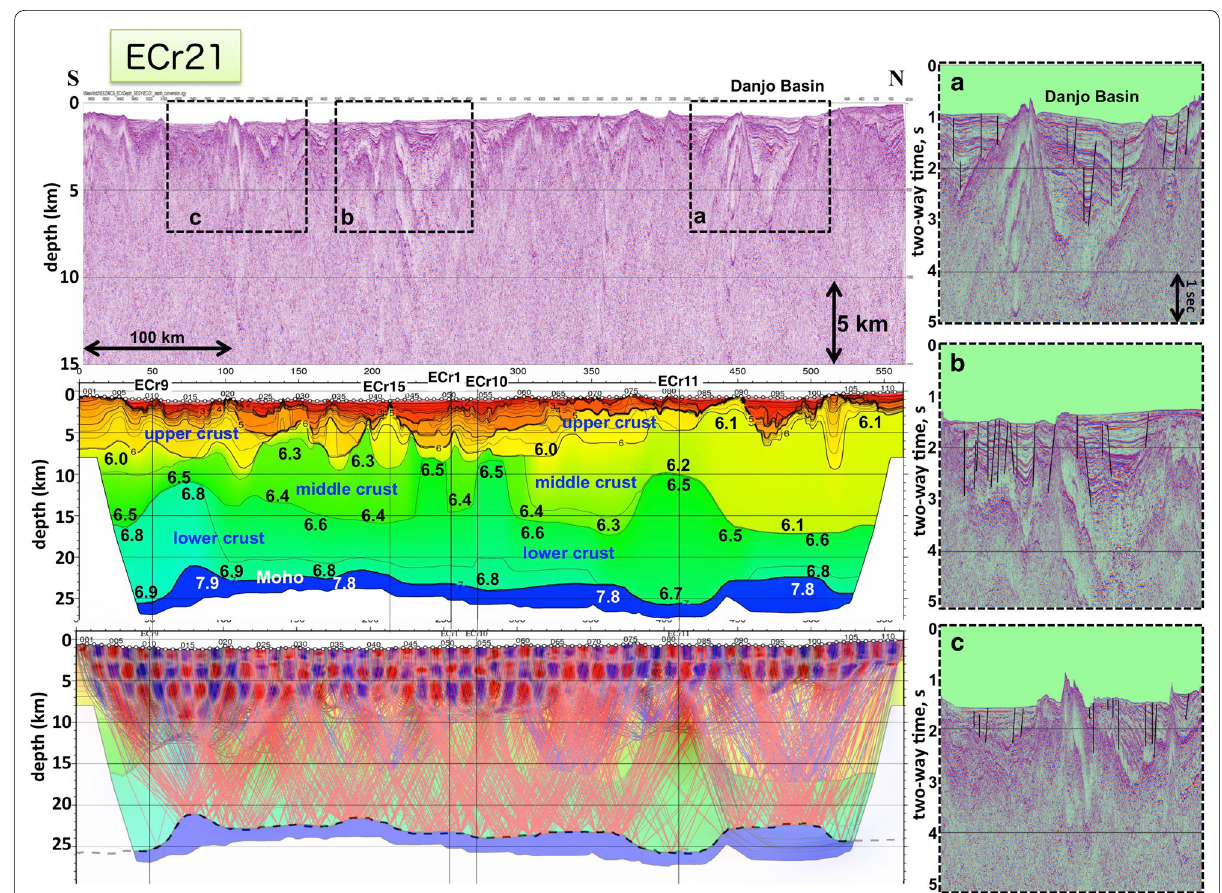
Fig. 12 MCS depth-converted profile (top left), V p model (middle left), and checkerboard test result with ray coverage (bottom left) for ECr21. The time sections for the three sedimentary basins in the top-left depth section are enlarged and displayed on the right. The black lines in the time sections indicate steeply dipping normal